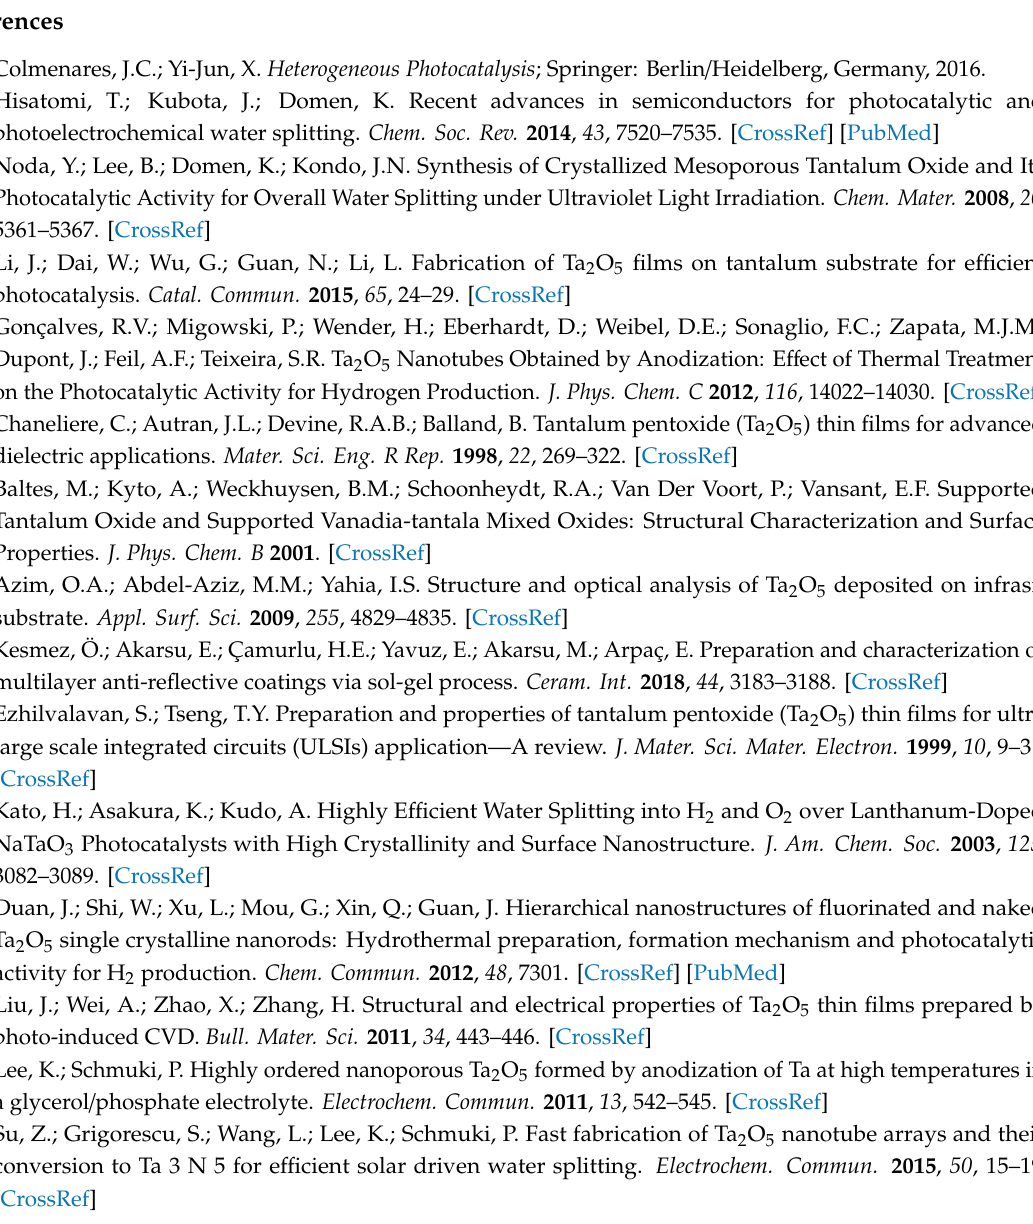
30 min (green) of irradiation. Figure S7: E ffi ciency of toluene removal in blank tests and during photodegradation (C 0 = 200 ppm). Figure S8: Kinetics of toluene degradation during irradiation over pristine tantalum pentoxide (Ta 2 O 5 ) nanotubes and bismuth sulfide (Bi 2 S 3 ) quantum dots (QDs) / Ta 2 O5 nanotube arrays (NTs) for an initial toluene concentration of 400 ppm. Figure S9: Surface of the samples ( a ) before and ( b ) after three cycles of photodegradation for NTs_15 V_5 min_N 2 _450 ◦ C_1 h_QDs_SILAR 1x. Table S1: Elemental composition (in at. %) in the surface layer of N 2 , NH 3 , H 2 , and air post-deposition annealed tantalum pentoxide (Ta 2 O 5 ) nanotube arrays (NTs). The relative contribution of Ta oxide states (in %) was evaluated after deconvolution of the Ta 4f X-ray photoelectron spectroscopy (XPS spectra). Table S2: E ffi ciency of the photodegradation of toluene upon irradiation with an Xe lamp (1000 W). Table S3: Size of quantum dots (QDs) and elemental composition (EDX) for nanotube arrays (NTs) modified by